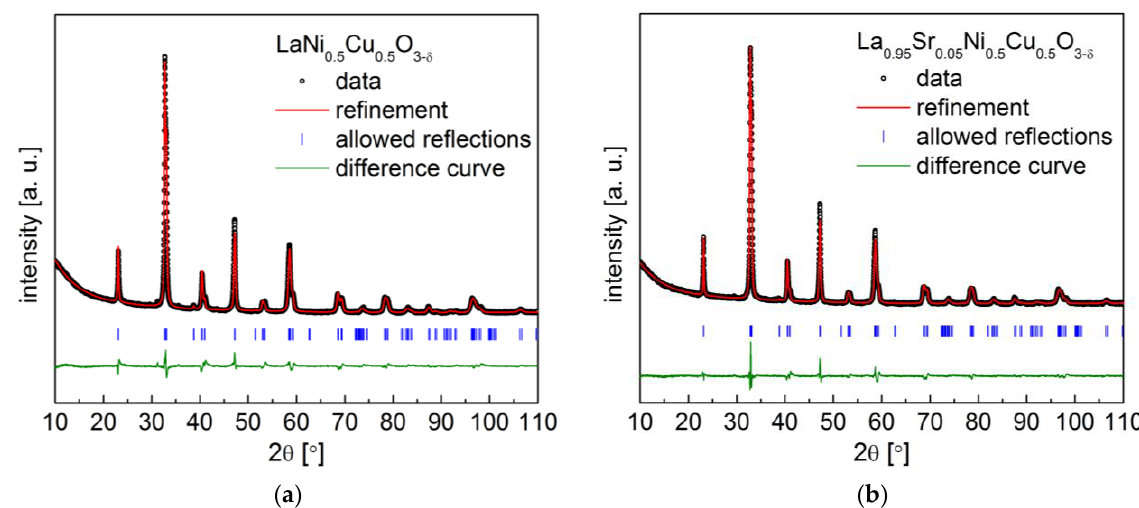
Figure 2. XRD patterns with Rietveld refinement recorded for La 1 − x Sr x Ni 0.5 Cu 0.5 O 3 − δ oxides with ( a ) x = 0; ( b ) x = 0.05.